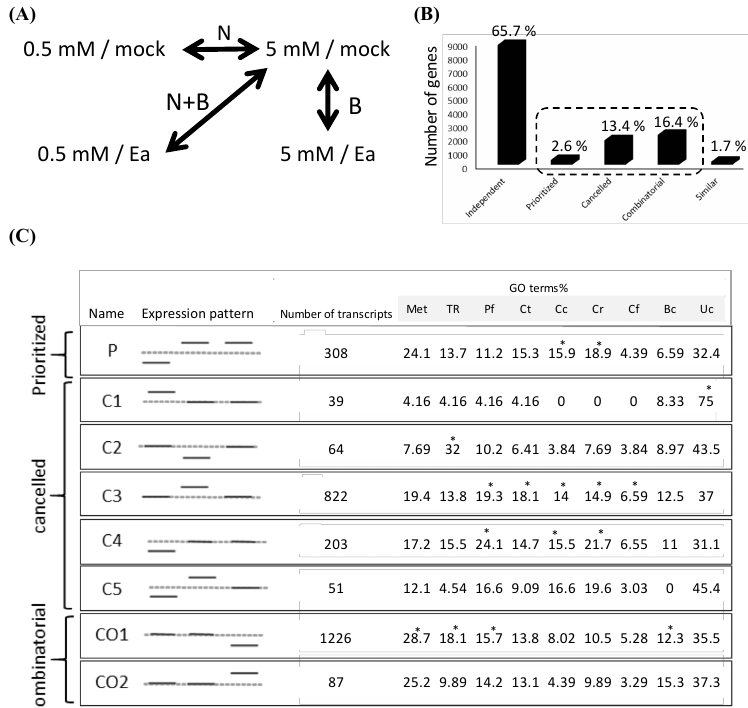
Figure 2. Gene expression patterns in response to single and combined stresses. ( A ) Schematic representation of single stresses (N:N limitation; B: Ea infection) and combined stresses (N + B:N limitation and Ea infection); arrows represent the dataset comparisons performed that are represented as “expression pattern” in (C). ( B ) Number of genes in the different categories of responses to stress combination; for each category, the percentage among the total modulated genes is indicated. The dotted line indicates the three nonpredictable categories, which represent one third of Ea -responsive transcripts. ( C ) Detail of the expression patterns among the different nonpredictable categories. Expression patterns: The dotted line represents transcript level in control plants (mock/5 mM NO 3 − ); the full lines correspond to N, B, and N + B (from left to right). For each subcategory, only the type of response is indicated with a full line (induced, repressed, no response). Enrichment in Gene ontology (GO) terms in each subcategory was determined according to the FunCatDB. Asterisks (*) indicate a significant difference relative to the Arabidopsis genome ( p -value < 0.05) . P: Prioritized, C: Cancelled, and CO: Combinatorial.